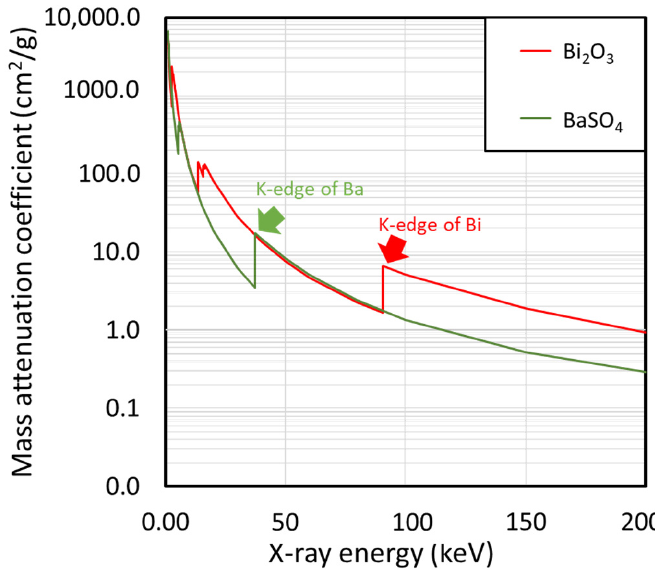
Figure 5. Mass attenuation coefficients ( µ m ) of Bi 2 O 3 and BaSO 4 at varying X-ray energies (1–200 keV), determined using XCOM.